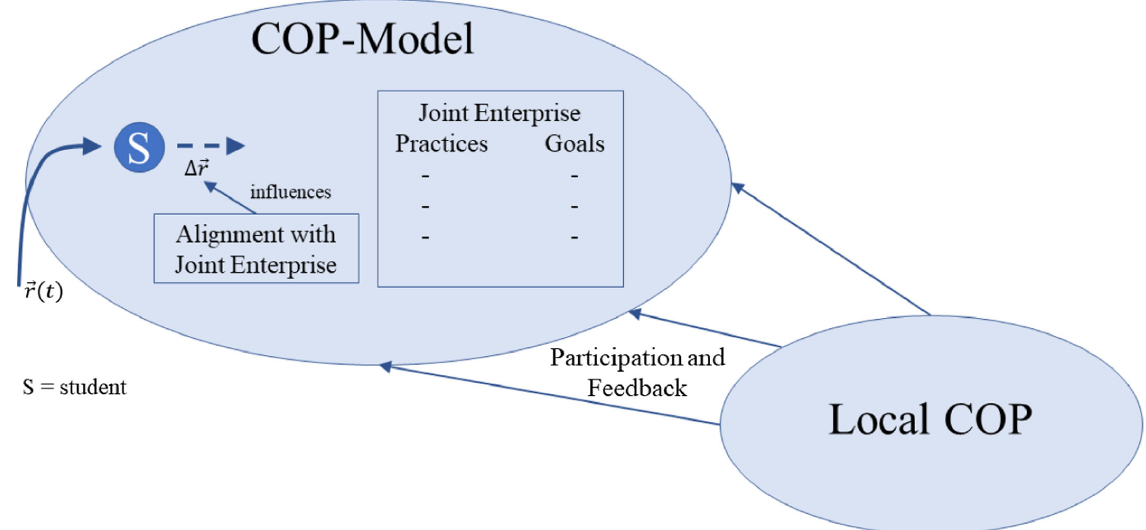
FIG. 2. The construct of a COP model. The student ’ s mental model includes their trajectory history [ ⃗ r ð t Þ ], their next step ( Δ ⃗ r ), and their understanding of the community ’ s sense of joint enterprise. Their next step is informed by their current sense of alignment with the sense of joint enterprise. All these elements are shaped by the legitimate peripheral participation in the local COP. We apply this construct specifically to the use of computation in physics education, but believe it can offer insights into all STEM